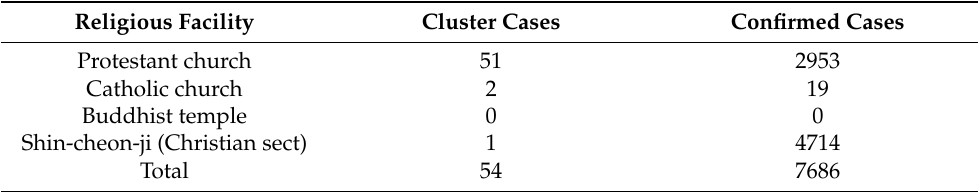
Table 2. Cluster cases originating from religious facilities (1 May 2020–24 February 2021).